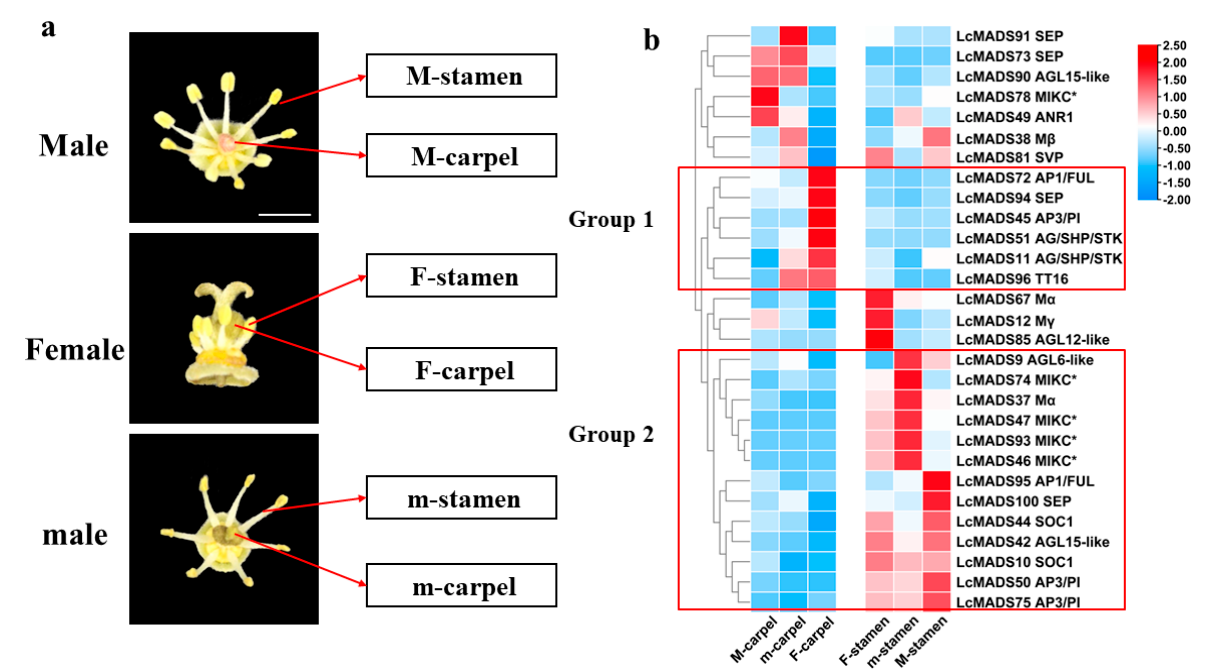
Figure 6. Expression profiles of litchi MADS-box genes in various floral organs. M-carpel, the carpels in full-bloom functionally male flowers (Male, M); M-stamen, the stamens in full-bloom functionally male flowers (Male, M); F-carpel, the carpels in full-bloom functionally female flowers (Female, F); F-stamen, the stamens in full-bloom functionally female flowers (Female, F); m-carpel, the carpels in full-bloom functionally male flowers (male, m); m-stamen, the stamens in full-bloom functionally male flowers (male, m) ( a ). FPKM values of litchi MADS-box genes derived from the transcriptome data were normalized to z-scores for each row to construct the heat map ( b ). Scaled log 2 expression values are shown from blue to red, indicating low to high expression level.